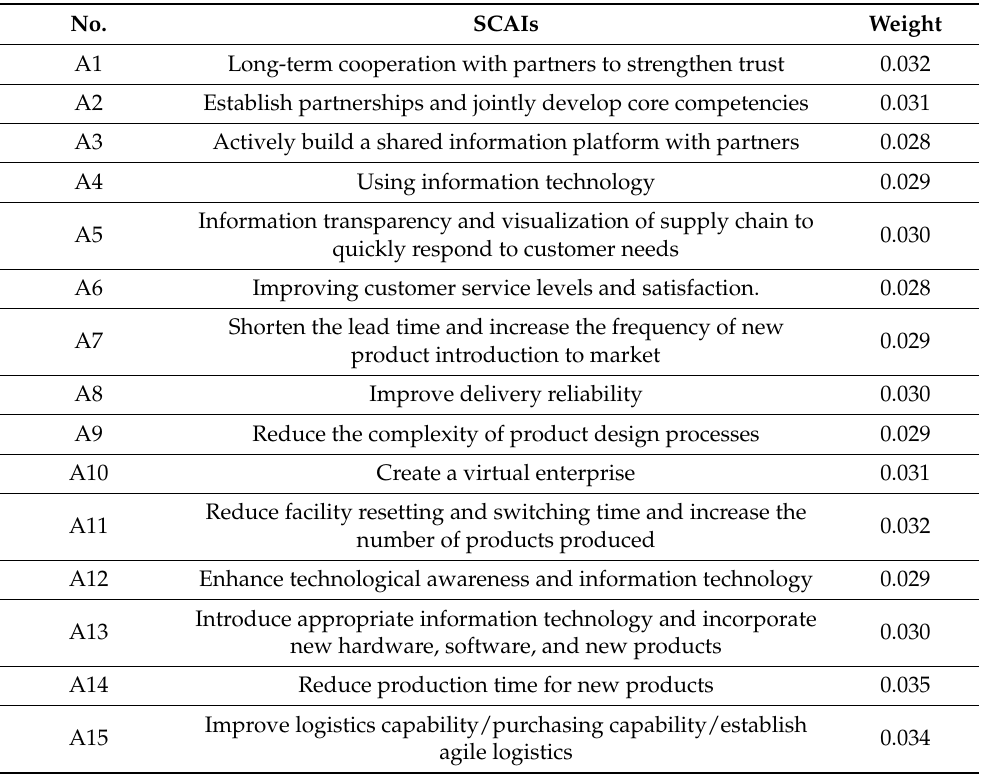
Table 4. Key agility indicators and weight